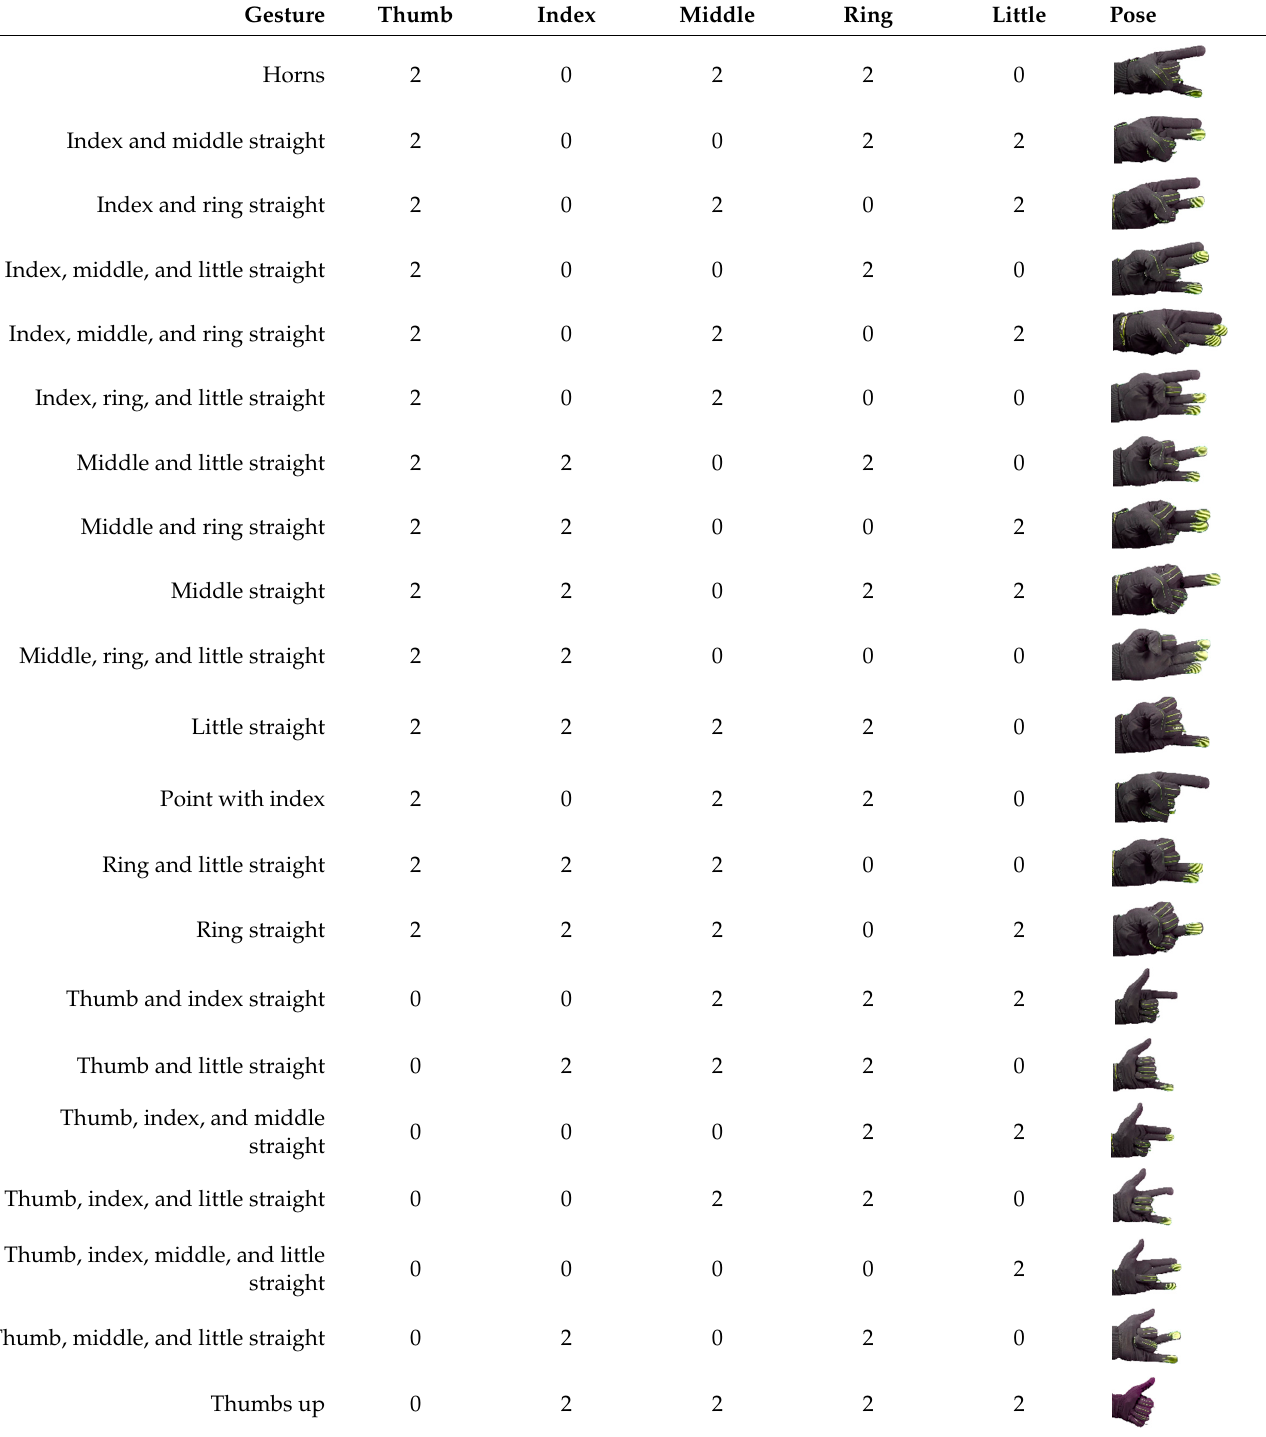
M2O2P includes 21 different hand gestures for use. A list of these gestures with their corresponding names, the states of the fingers, and images are presented in Table 1. Table 1. All 21 gestures and the corresponding bending states. State of fingers’ bending is presented as numbers varying from 0 (straight, over the upper threshold) to 2 (bent, under the lower threshold). Gesture